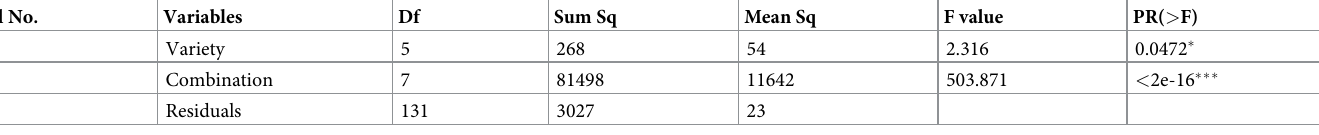
Table 11. ANOVA results for root induction. Sl